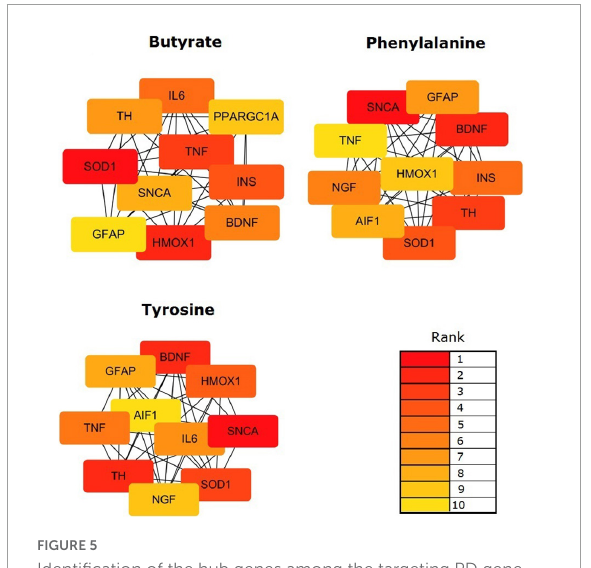
FIGURE5 Identification of the hub genes among the targeting PD gene sets of the validated metabolites. Network analyses were conducted by using a Cytoscape plug-in CytoHubba. The top 10 genes in the networks were identified by Maximal Clique Centrality (MCC) scores and